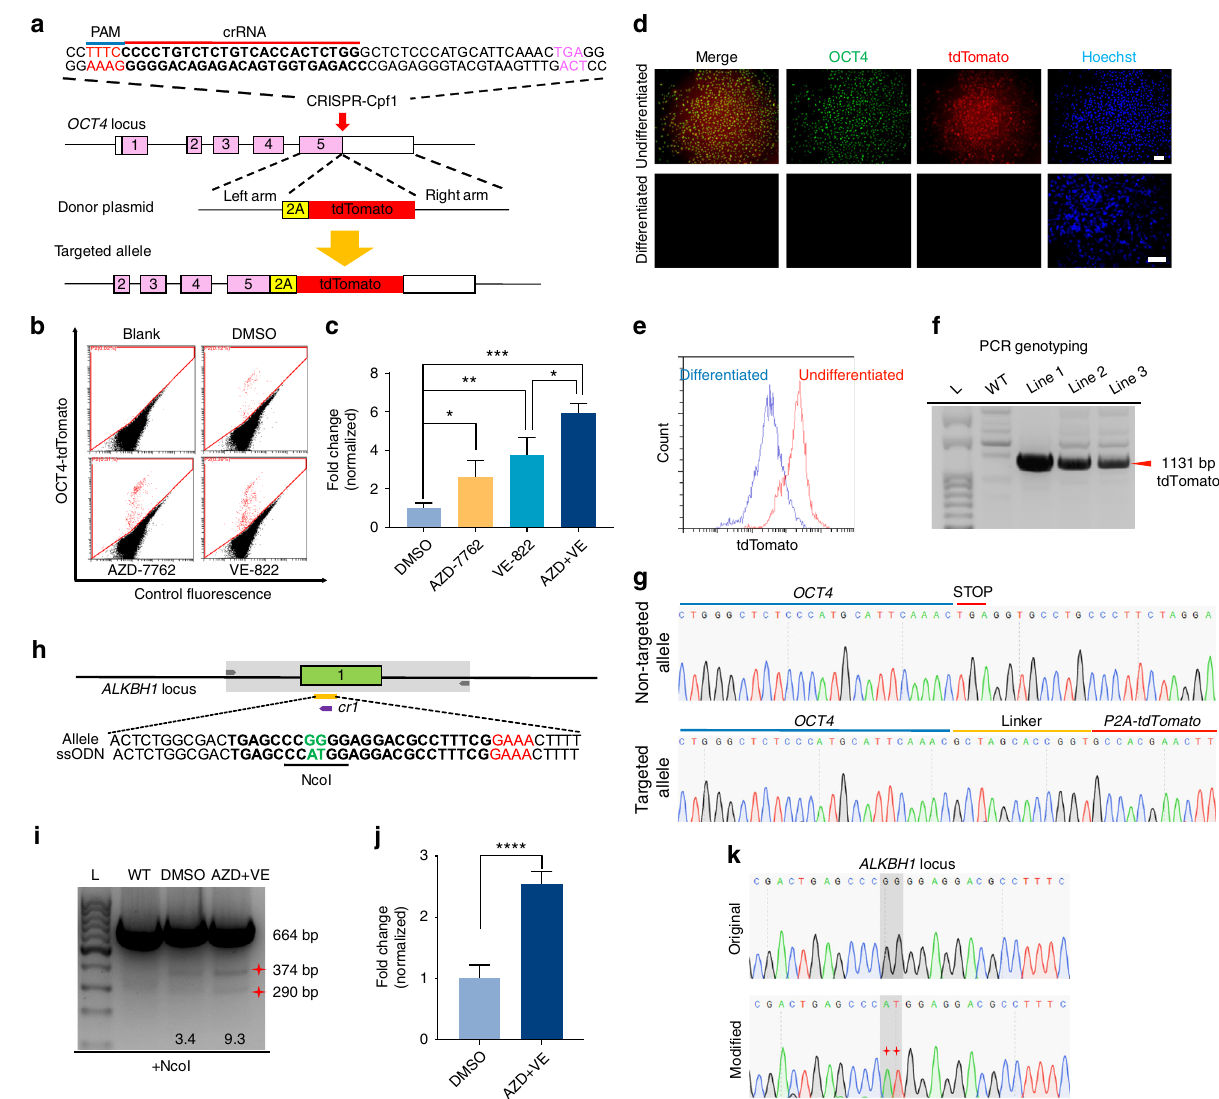
Fig. 3 Small molecules signi fi cantly promote CRISPR-Cpf1-mediated generation of knockin hPSC lines without drug selection. a A scheme of the targeting strategy of OCT4-2A-tdTomato. b FACS analysis for OCT4-tdTomato-positive cells after transfection of the OCT4-tdTomato donor plasmid and the OCT4-targeting crRNA into hPSCs. A representative FACS result of samples treated with DMSO, VE-822, and AZD-7762 was shown. c Addition of VE- 822 and AZD-7762 increased the percentage of OCT4-tdTomato-positive cells. n = 3 experiments. Statistical signi fi cance calculated using two-tailed Student ’ s t -test, compared to DMSO controls. * P < 0.05, ** P < 0.01 *** P < 0.001. d Characterization of OCT4-tdTomato reporter lines. Scale bar, 100 μ M. e FACS analysis of OCT4-tdTomato reporter lines. Undifferentiated line is in red, and differentiated line is in purple. f PCR genotyping of OCT4-tdTomato reporter lines. The size of expected bands is 1131 bp. g Sequencing results of the non-targeted allele and at the junction of correctly targeted allele in OCT4- tdTomato reporter lines. h A scheme of ssODN-mediated genome editing. We used ALKBH1 – cr1 and a synthesized 120-nt ssODN template to introduce point mutations, which could be detected by RFLP assay. i The RFLP assay result. NcoI was used to evaluate the ssODN-mediated knockin ef fi ciency. j VE- 822 and AZD-7762 could promote ssODN-mediated genome editing by almost 3-fold. n = 4 experiments. Statistical signi fi cance calculated using two- tailed Student ’ s t -test, compared to DMSO controls. **** P < 0.0001. k Sanger sequencing con fi rmed the successful introduction of point